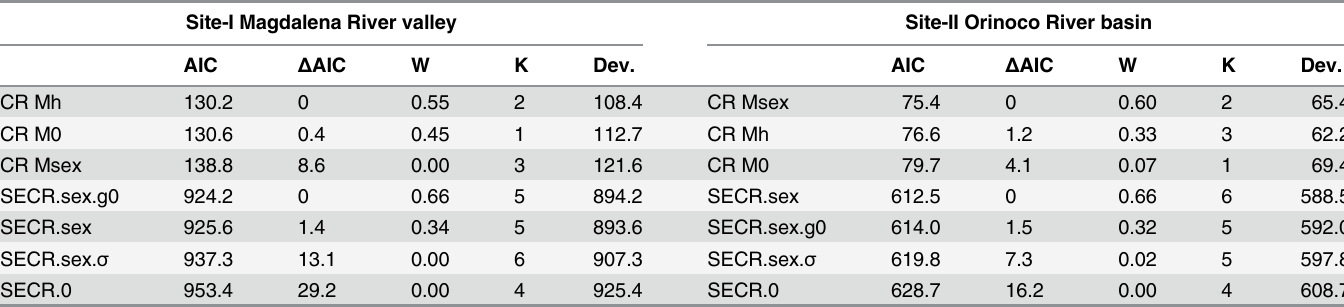
Table 2. Model selection parameters for both Capture-Recapture (CR) and Spatially Explicit Capture Recapture (SECR) models at Site-I and Site-II. Site-I Magdalena River